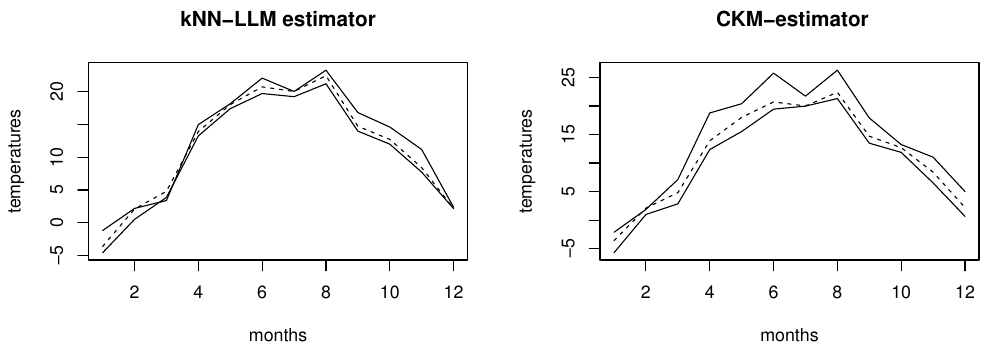
Figure 3. Prediction and confidence bands by SCMI-rule.